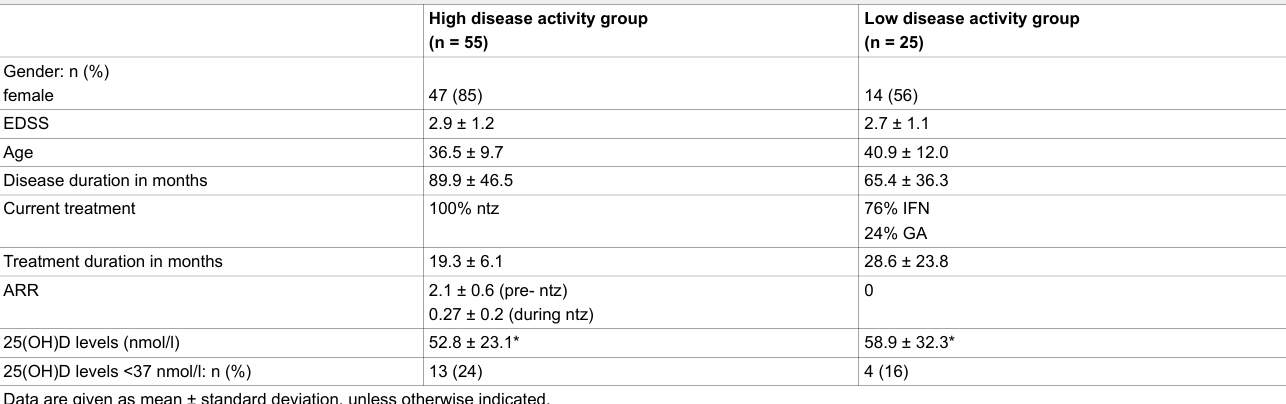
Table 1: Demographic data and patient characteristics at baseline in patients with high disease activity (n = 55) and low disease activity (n = 25).